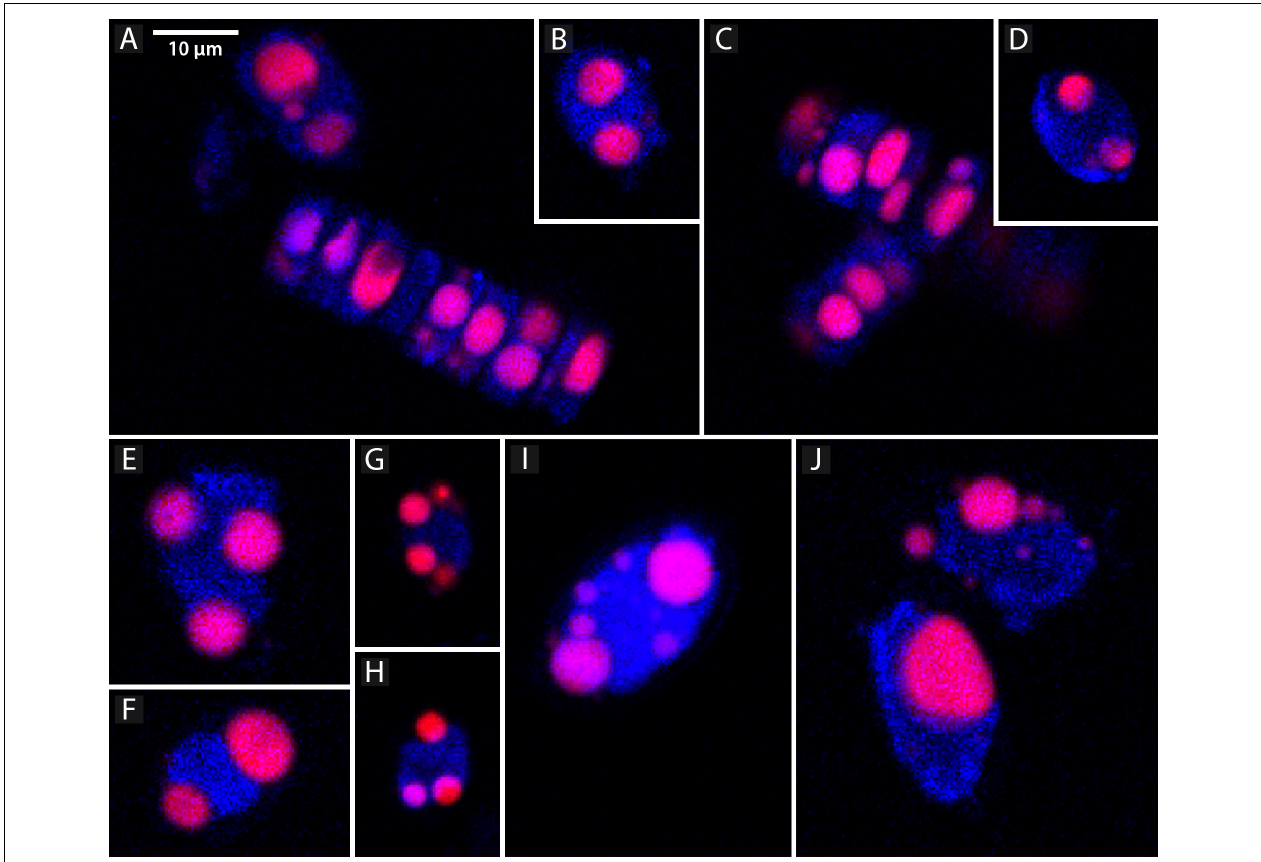
FIGURE 7 | Representative confocal microscope images showing lipid droplets, stained with the Nile Red (red channel) and chlorophyll (blue channel) in different strains of Schizostauron spp. (A,B) SZCZ E1420, (C,D) SZCZ E1421, (E,F) SZCZ E1425, (G,H) SZCZ E1427, (I,J) SZCZ